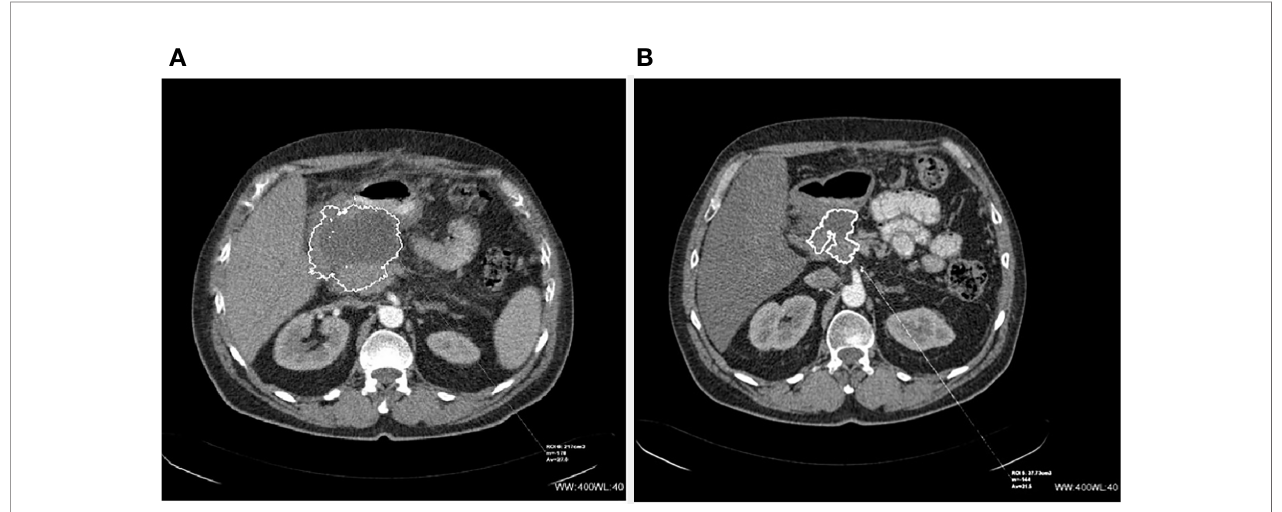
FIGURE 1 | CT scans of inoperable (before and after PRRT) NET of the pancreas: (A) before PRRT and (B) 4 months after 4 cycles of